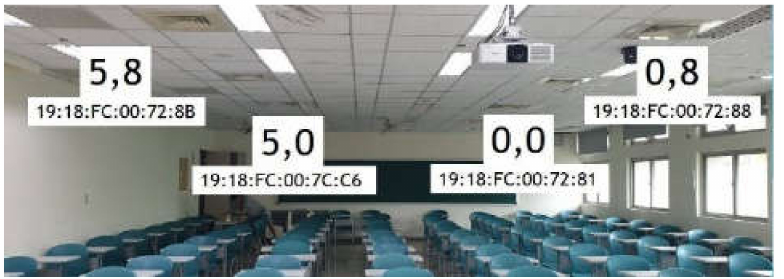
Figure 4. The experimental environment for the FPFE method in a 5 m × 8 m area. Reprinted from ref. [39]. © IEEE 2021.